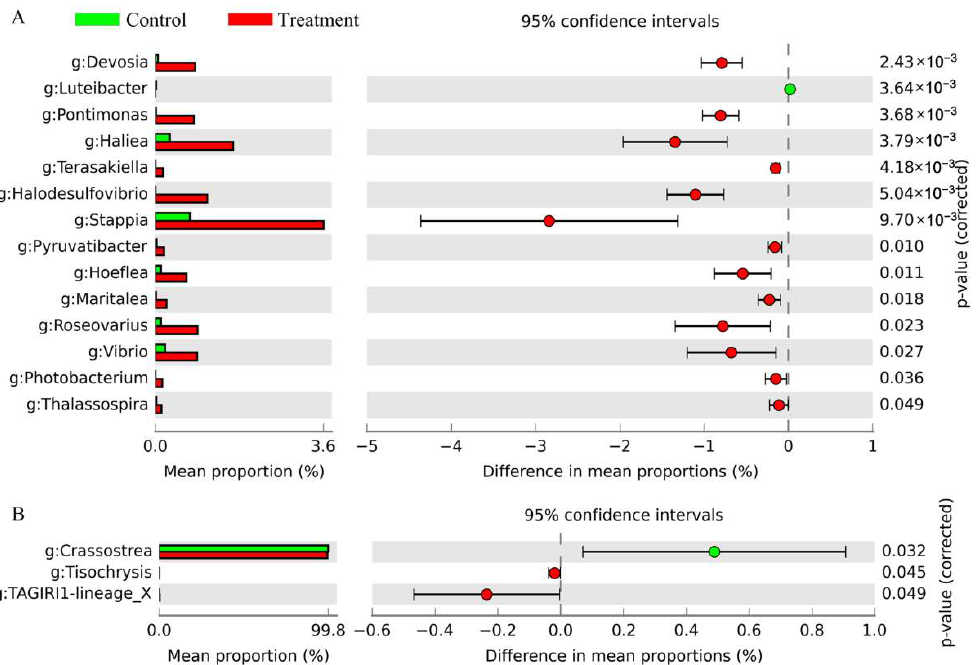
Figure 4. STAMP analysis identifying the significant differences of relative abundances of dominant taxa of the prokaryotes ( A ) and eukaryotes ( B ) at the genus level in control (green) and treatment (red) groups (95% confidence intervals) by using extended error bar plot. Corrected p- values are shown on the right. g represents the taxon at genus level.